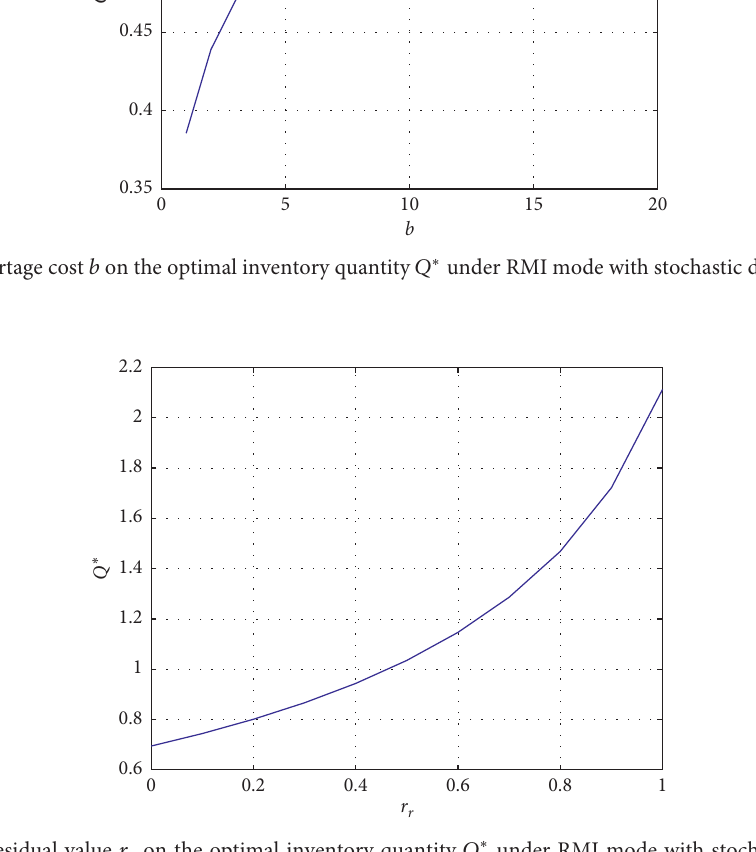
Q ∗ under RMI mode with stochastic demand in the water r on the optimal inventory quantity